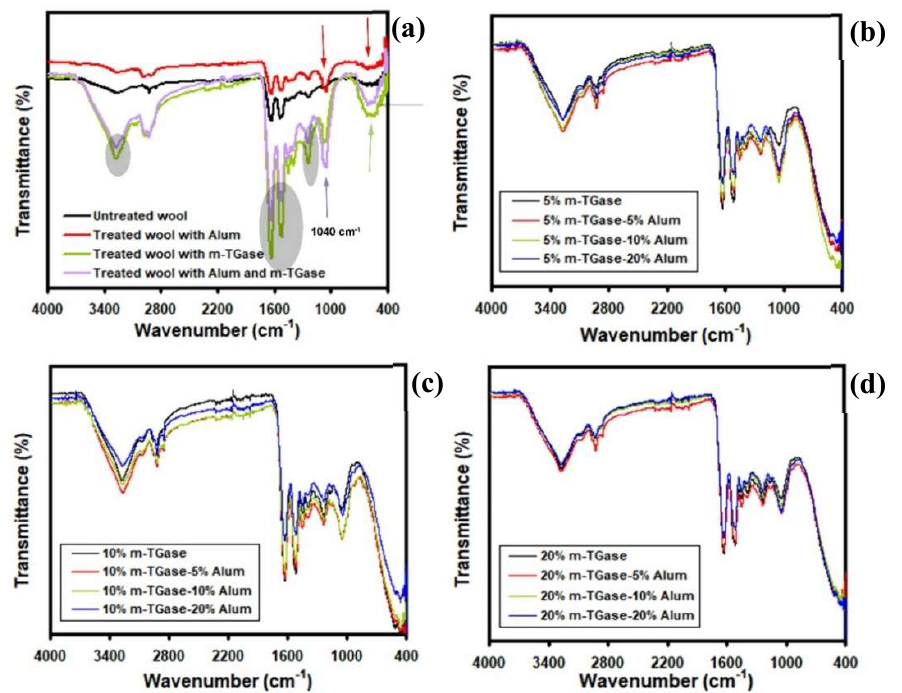
Figure 1. FT-IR spectra of ( a ) untreated and treated wool with microbial transglutaminase (m-TGase), alum, and alum-m-TGase; Treated wool with ( b ) 5%; ( c ) 10%; ( d ) 20% m-TGase with various concentrations of alum.